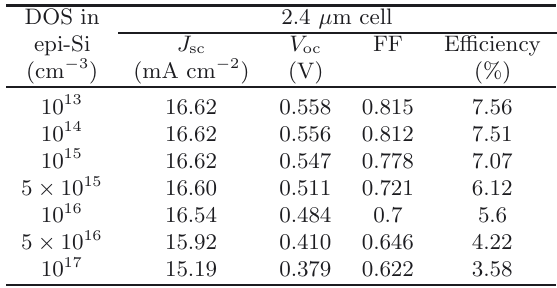
Table 4. Sensitivity to the Gaussian defect density inside the epitaxial silicon